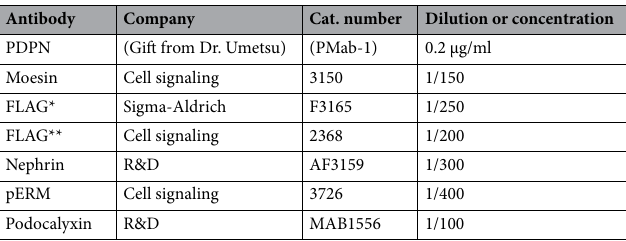
Table 1. Antibodies for